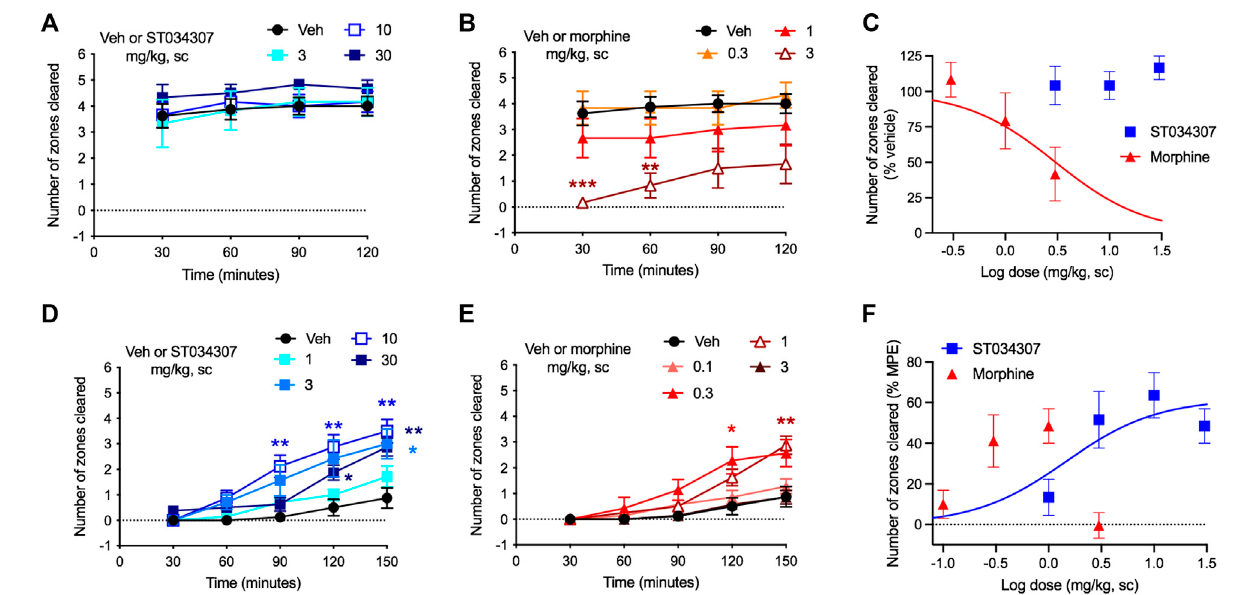
FIGURE3| ST034307 rescuesacid-depressed mouse nestingbehavior. (A) ST034307 did not reduce mouse nesting behavior at dosesupto 30 mg/kg. (B) Ata dose of 3 mg/kg, morphine signi fi cantly reduced mouse nesting behavior at 30 and 60 min after nesting measurements were started. (C) Dose-response curves of the last experimental timepoints the graphs in (A) and (B) . Vehicle ’ s response was set as 100% and the maximal possible effect (0) to 0%. (D) and (E) 3 mg/kg, 10 mg/kg, and 30 mg/kg ST034307 and 0.3 mg/kg and 1 mg/kg morphine signi fi cantly rescued mouse nesting behavior that was reduced by an intraperitoneal injection of 1%lacticacid. (F) Dose-responsecurves ofthelastexperimental timepoints from thegraphsin (D) and (E) .Vehicle ’ sresponsewasset as0%and themaximalpossible effect (5) to 100%. Data in all graphs represent the average ±S.E.M., N = 6 – 8. * p < 0.05, ** p < 0.01, *** p < 0.001 in two-way ANOVA with Dunnett ’ s test.